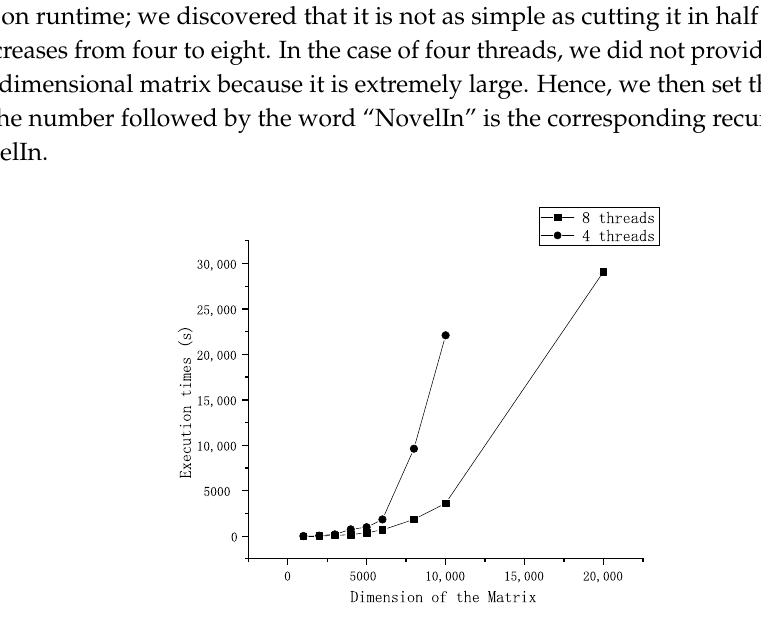
Figure 2. The impact of different threads on the G-J’s